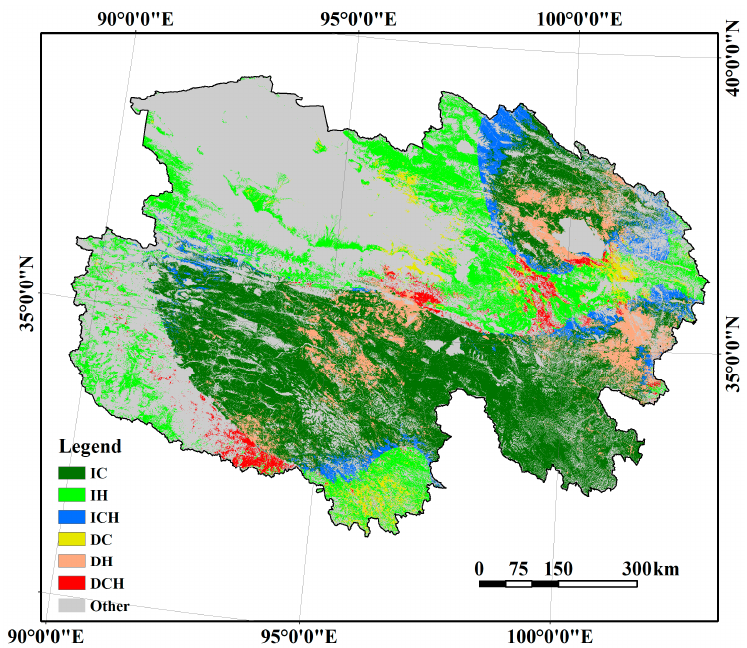
Figure 5. Spatial patterns of driving forces for NPP a changes from 2001 to 2016. 249